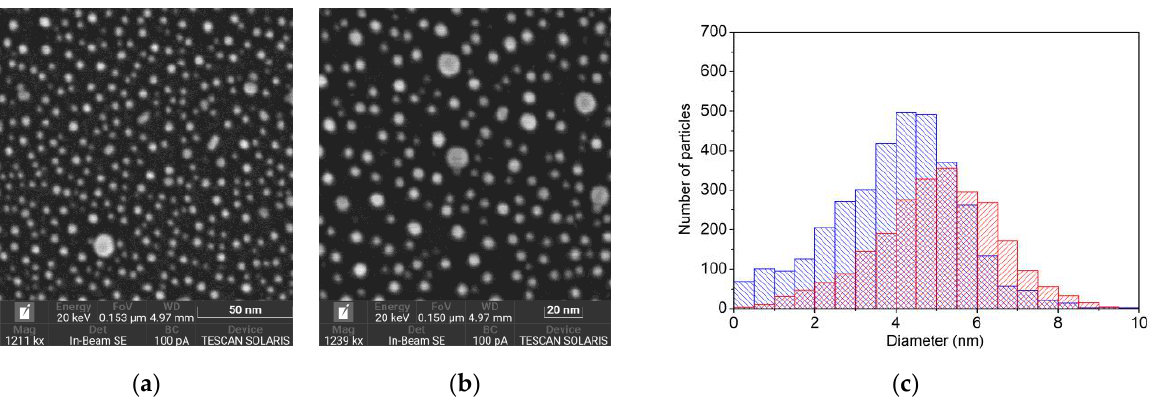
Figure 8. ( a ) A fragment (153 × 153 nm) of the SEM image of the intact silicon wafer surface with deposited Au nanoparticles. ( b ) A fragment (150 × 150 nm) of the SEM image of the silicon wafer surface with deposited Au nanoparticles after 3 min of scanning with pulsed laser radiation (laser pulse energy of 1.2 μJ ). ( c ) Histogram of the nanoparticle diameter distribution before (blue) and after (red) laser exposure. The Au nanoparticles were deposited by about 500 laser pulses at an ablating laser pulse energy of 10 μJ.